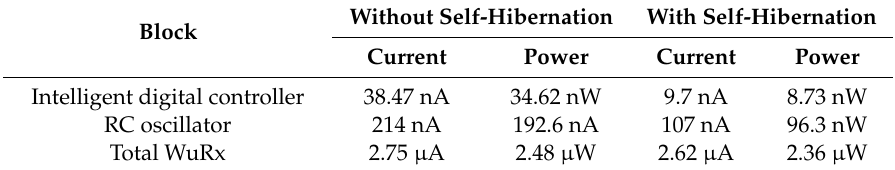
Table 2. Power consumption summary with and without self-hibernation.